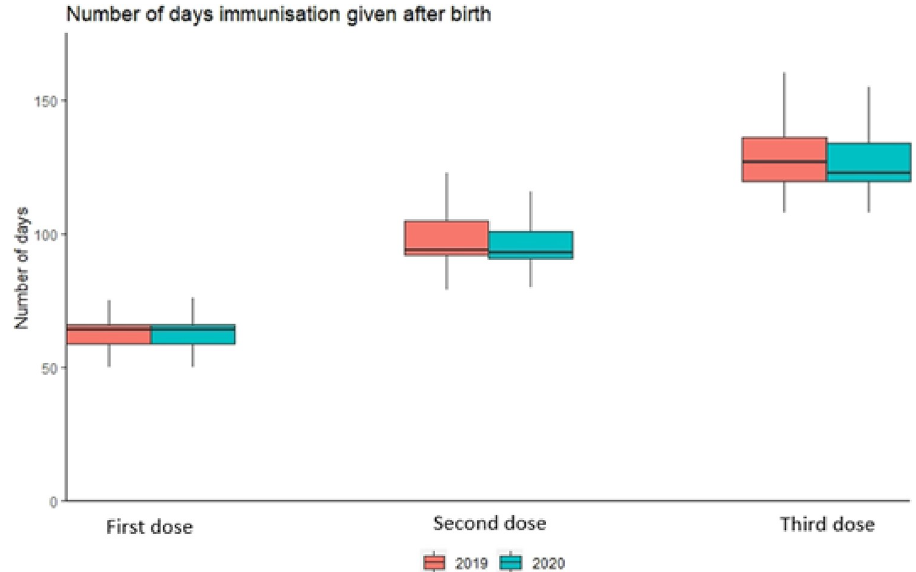
Fig 4. Differences in timings of immunisations given in 2019 and 2020 at the recommended intervals. The number of days after birth that infants receive their primary immunisations. The first, second and third doses relate to all immunisations that are usually due at 8, 12 and 16 weeks of chronological